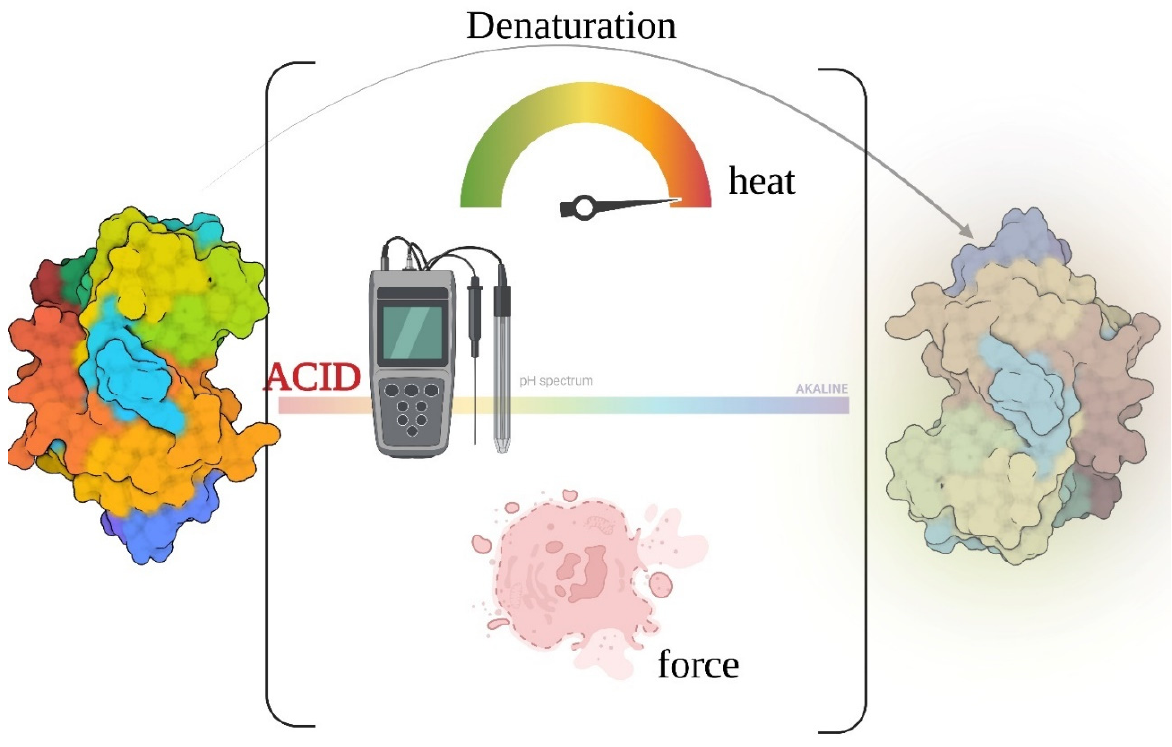
Figure 1. Denaturation of blood proteins with changes in temperature, environmental pH, and mechanical shocks [23] (with permission from Elsevier).